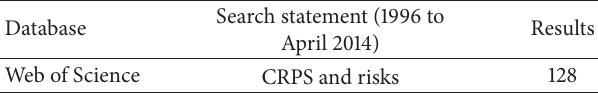
Table 1: Search terms for Web of Science CRPS 1 risks.